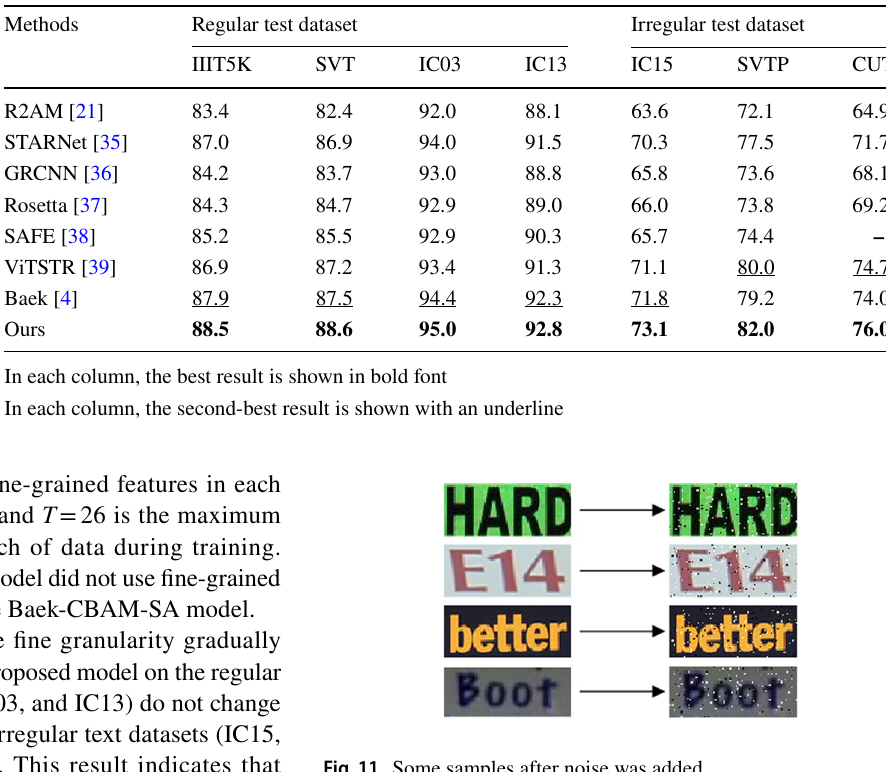
Table 3 Comparison of accuracy of text recognition of multiple models on test set